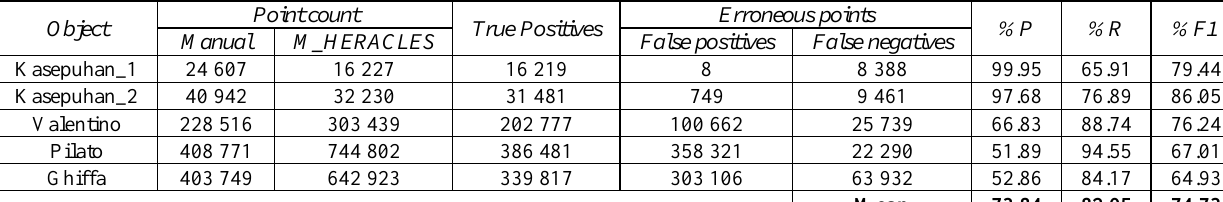
Table 1. Table presenting the results of automatic pillar detection and classification using M_HERACLES for the five available